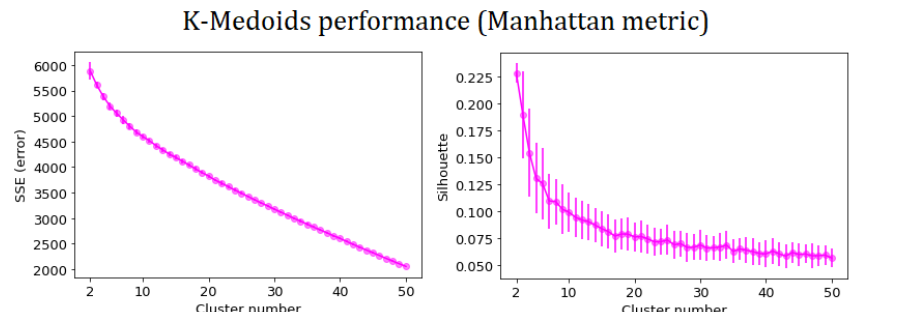
Figure 6. SSE (panels in the left column ) and mean Silhouette value (panels in the right column ) of K- medoids clustering for StartupBlink countries, at different fixed numbers of clusters, with three kinds of metric. Error bars are determined by the variance of the considered quantities over 100 runs of the algorithm. The absence of an elbow-point in the SSE plots, along with the maximum mean Silhouette values obtained for k = 2, where SSE also reaches its maximum, implies that K-medoids algorithms, with the considered metrics, are not well suited for an efficient partition of StartupBlink countries.